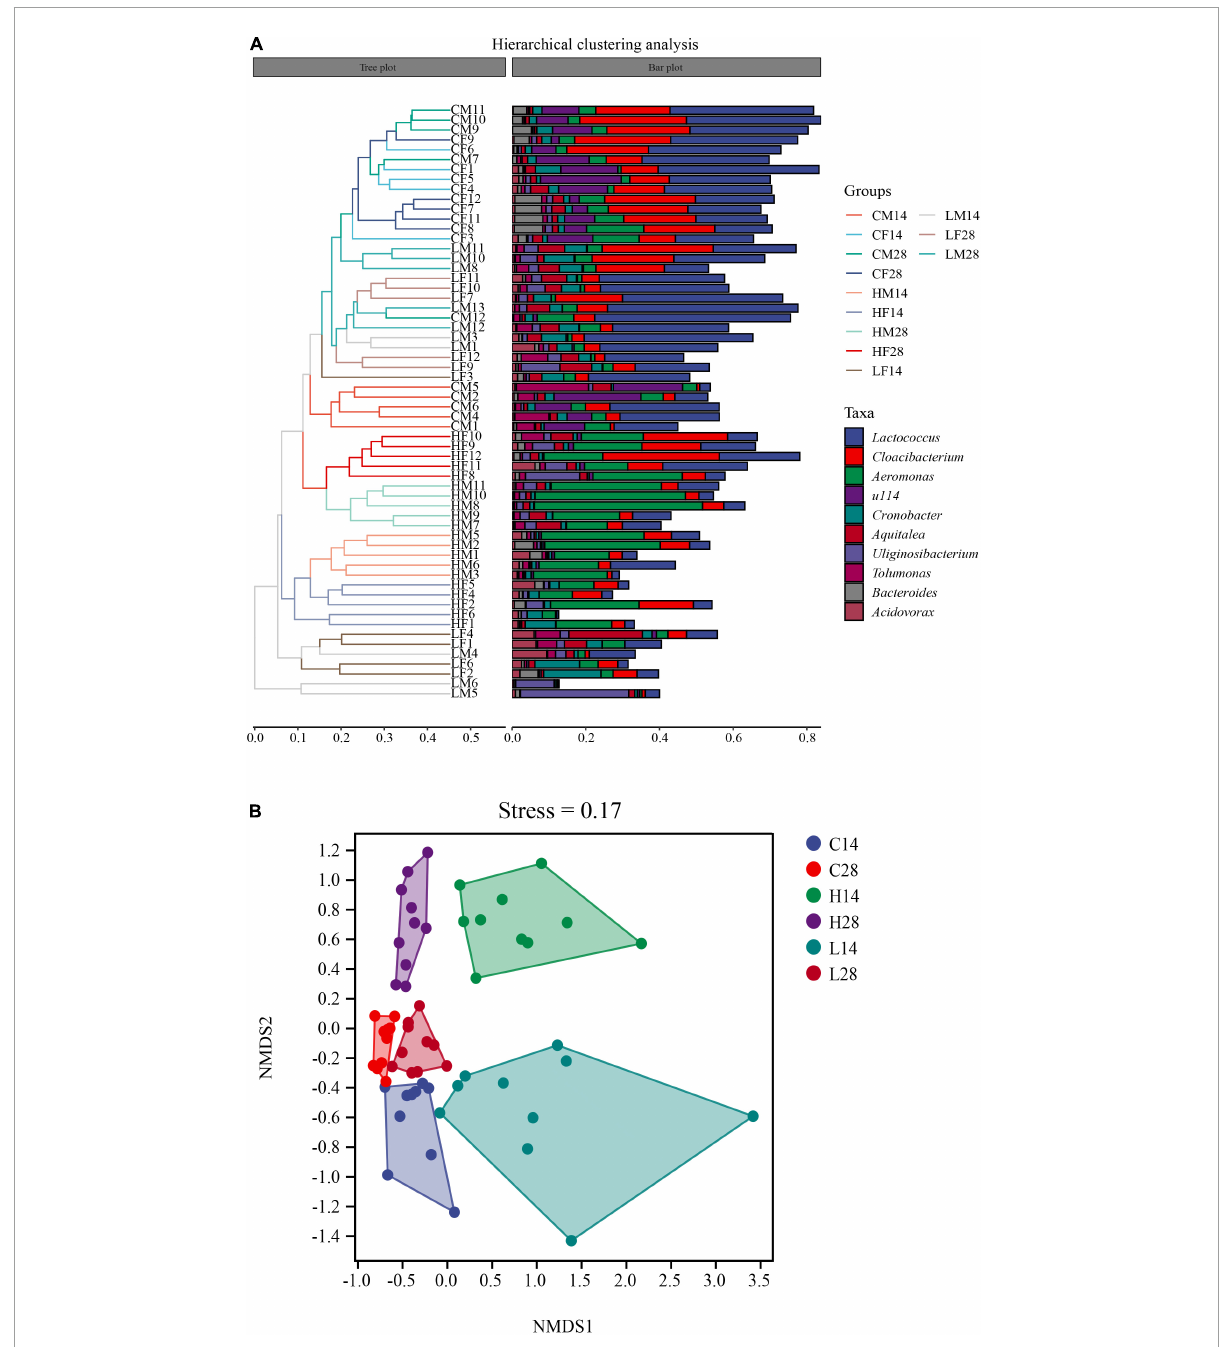
FIGURE5 The UPGMA cluster analysis of samples in Bray-Curtis distances (A) ; NMDS analysis based on Bray-Curtis distances of intestine microbiome (B) .